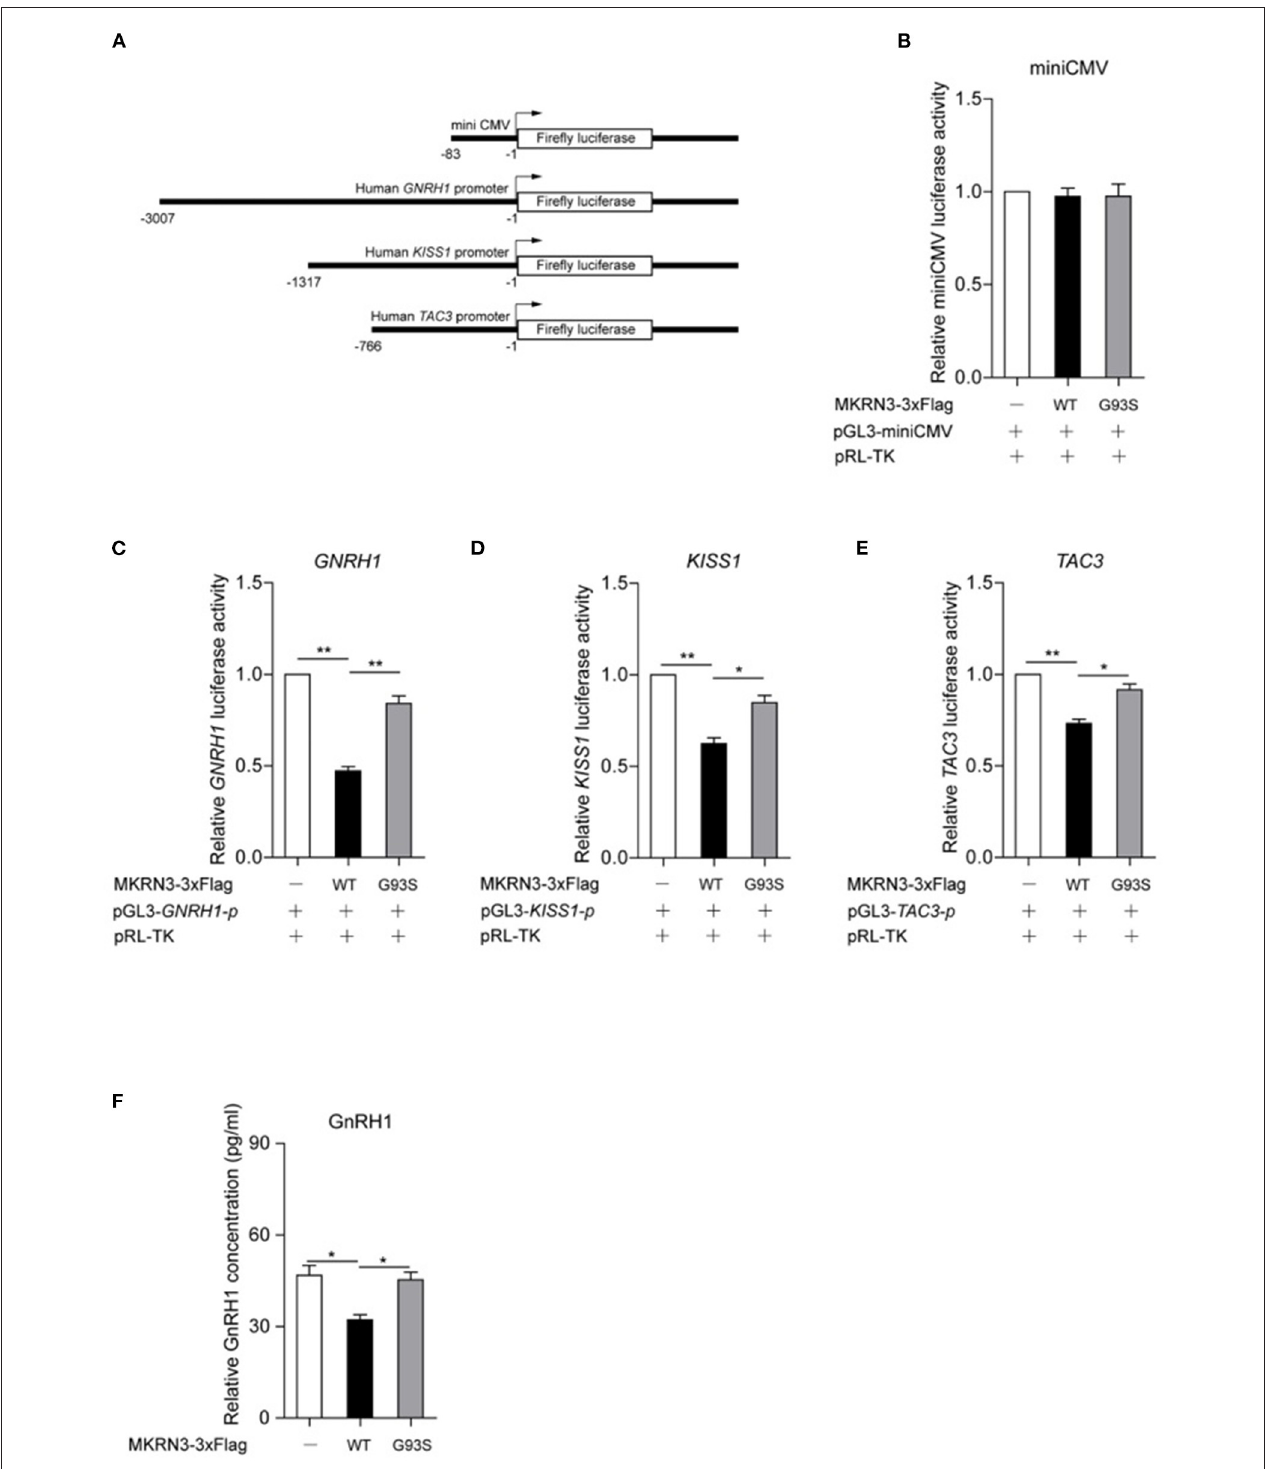
FIGURE 3 | Mutation of MKRN3 attenuated its inhibition on GnRH1-related signaling. (A) Schematic diagrams for the construction of luciferase reporter vectors for the human GNRH1 , KISS1, and TAC3 gene promoters. The indicated region of promoters was amplified and inserted into the pGL3-basic vector. The miniCMV promoter was inserted and acted as a negative control. (B–D) A luciferase reporter assay was used to detect the relative activities of (B) miniCMV, (C) GNRH1 , (D) KISS1, and (E) TAC3 promoters in HEK293T cells. HEK293T cells were transfected with the indicated plasmids and luciferase activities were detected. Data